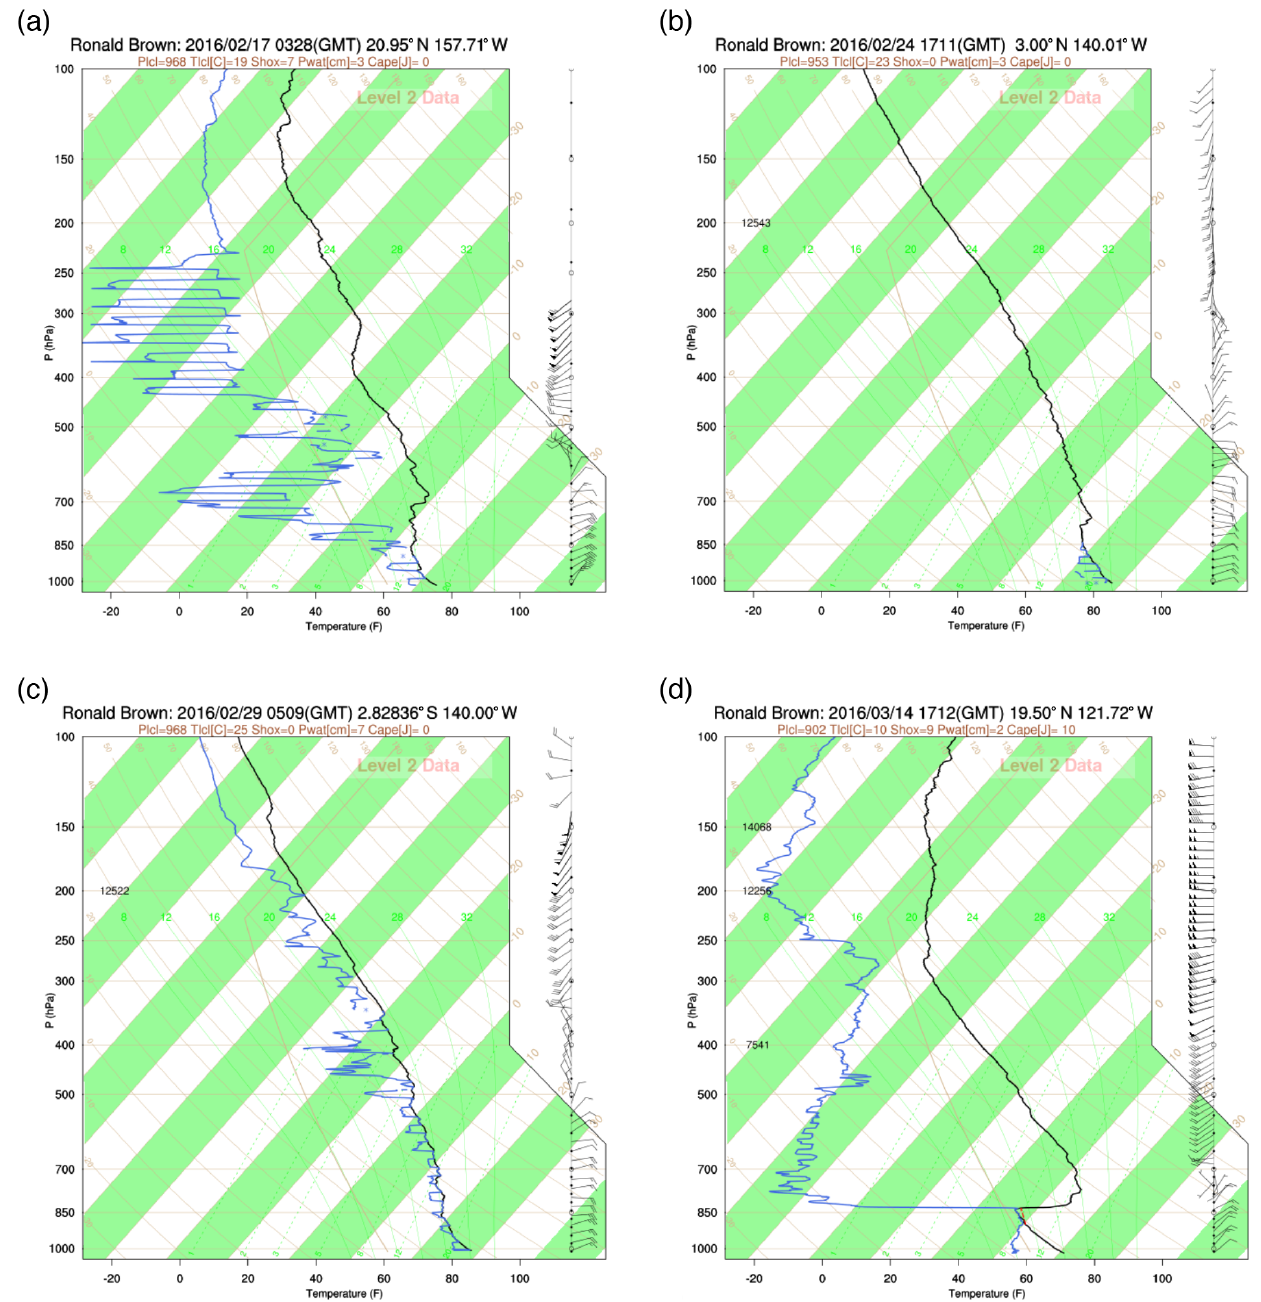
Figure 7. Examples of soundings with humidity issues that pass through ASPEN automated quality control.